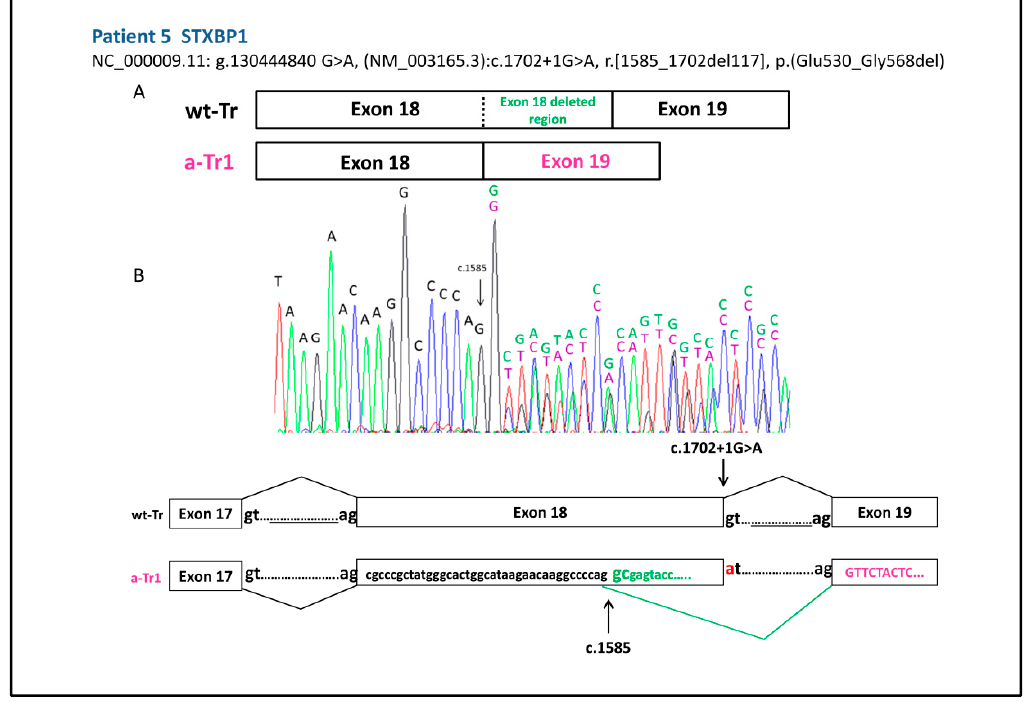
Figure 2. ( A ) Schematic representation of the wild type (wt-Tr) and the aberrant transcript (a-Tr1) generated by variant NC_000009.11: g.130444840 G>A, (NM003165.3), c.1702 + 1G>A of patient 5, resulting in the deletion of the last 117bp of exon 18. ( B ) cDNA electropherogram showing the wt transcript (black and green letters) and the aberrant transcript (black and purple letters) produced through the choice of a new donor site within exon 18 at position c.1585